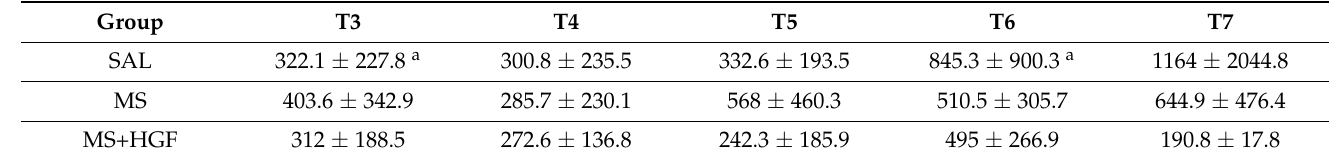
Table 4. IL-12. Mean values ± standard deviations of cytokine IL-12 (pg/mL).